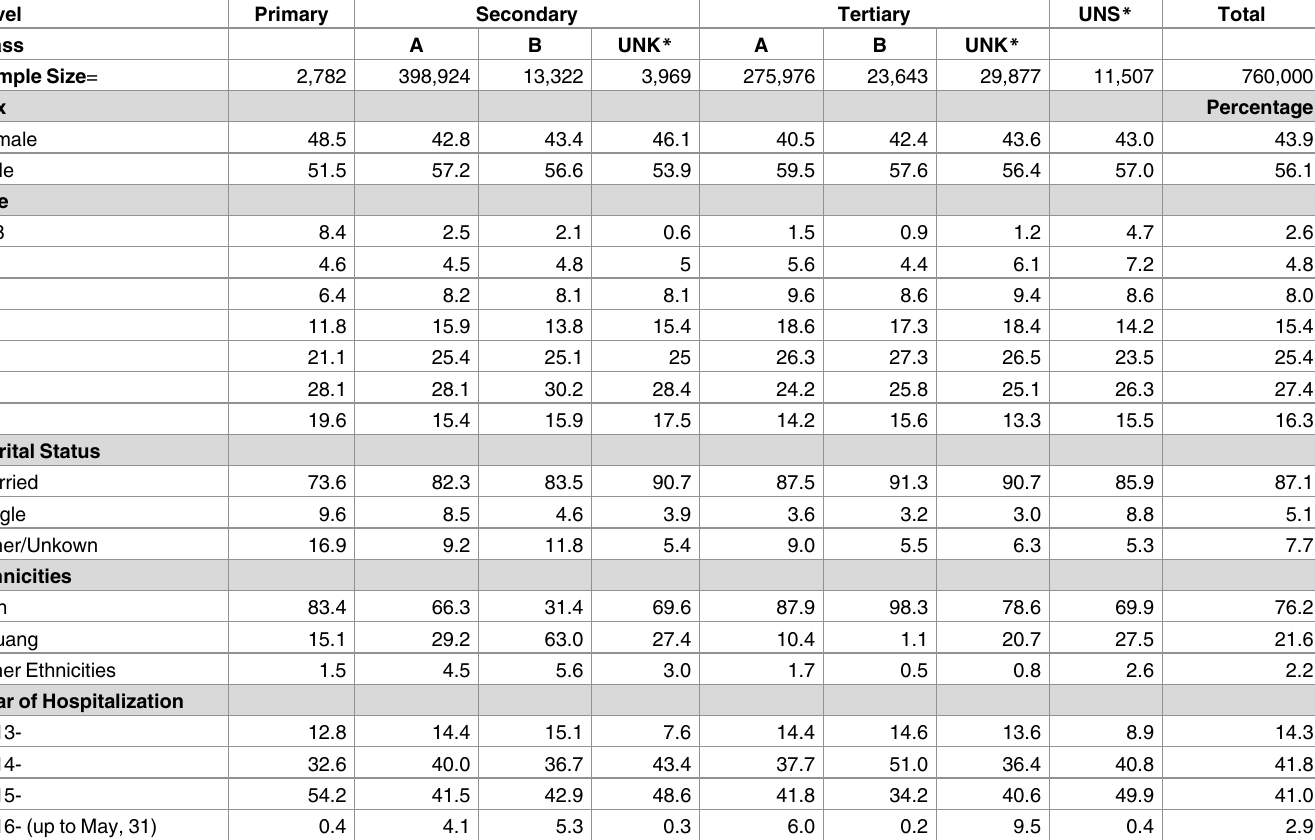
Table 1. Distributions of all hospitalized patients across different levels and classesof hospitals, with respectto gender, age, marital status, eth- nicity, and year of hospitalizations under the